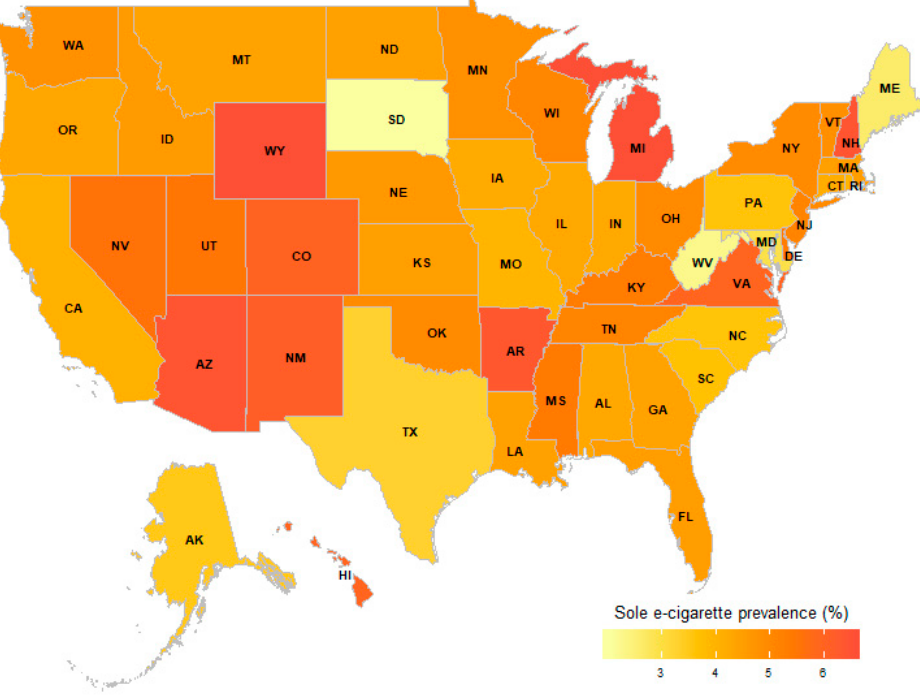
Figure 1. State-specific Prevalence of E-cigarette Use by Young Adult Never Smokers of Conventional Cigarettes, in 2016 and 2017 Combined. Table 2. Association Between Current E-cigarette Use and the Variables Selected by the Machine Learning Algorithms.